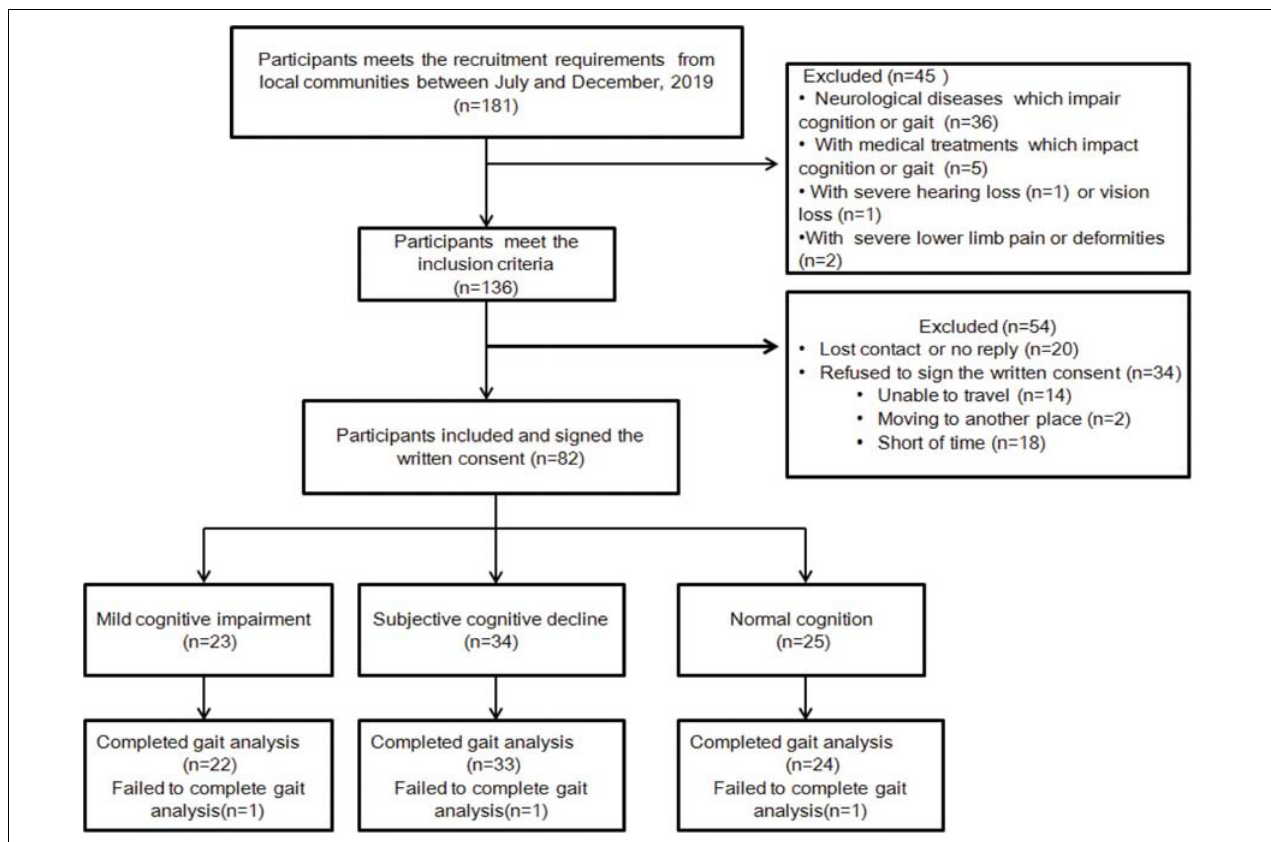
FIGURE 1 | Flowchart of the